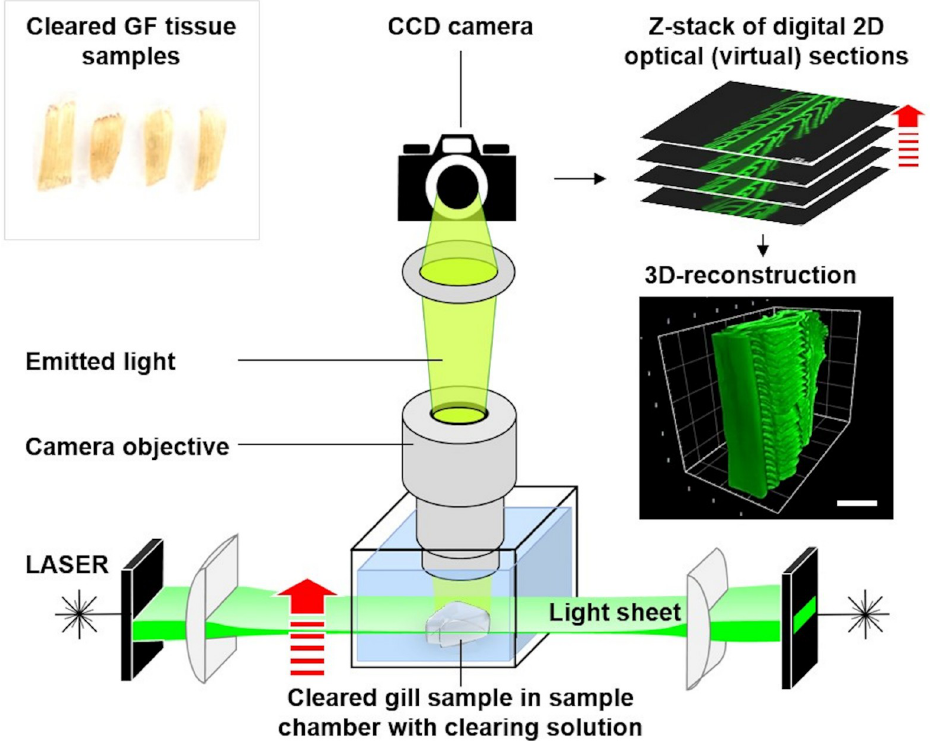
Fig 17. Laser light sheet fluorescence microscopy (LSFM) of an optically cleared gill filament sample. The cleared GF sample in the sample chamber is stepwise illuminated by thin laser light sheets of defined wavelength ranges. Here, autofluorescence signals emitted by GF structures excited by the laser light energy are detected by a digital charge- coupled device (CCD) camera, resulting in a 2-D fluorescent image of the illuminated focus plane in the sample. The sample is gradually moved through the laser light sheet(s) along its vertical axis (red arrow), resulting in the acquisition of a z-stack of serial fluorescence images, used to compute a 3-D reconstruction of the sample. In the present example, autofluorescence images of a 3DISCO-cleared GF sample acquired at 520/40 nm (excitation range) (ex) and 585/40 nm (emission range) (em) are shown. Bar = 200 μ m.